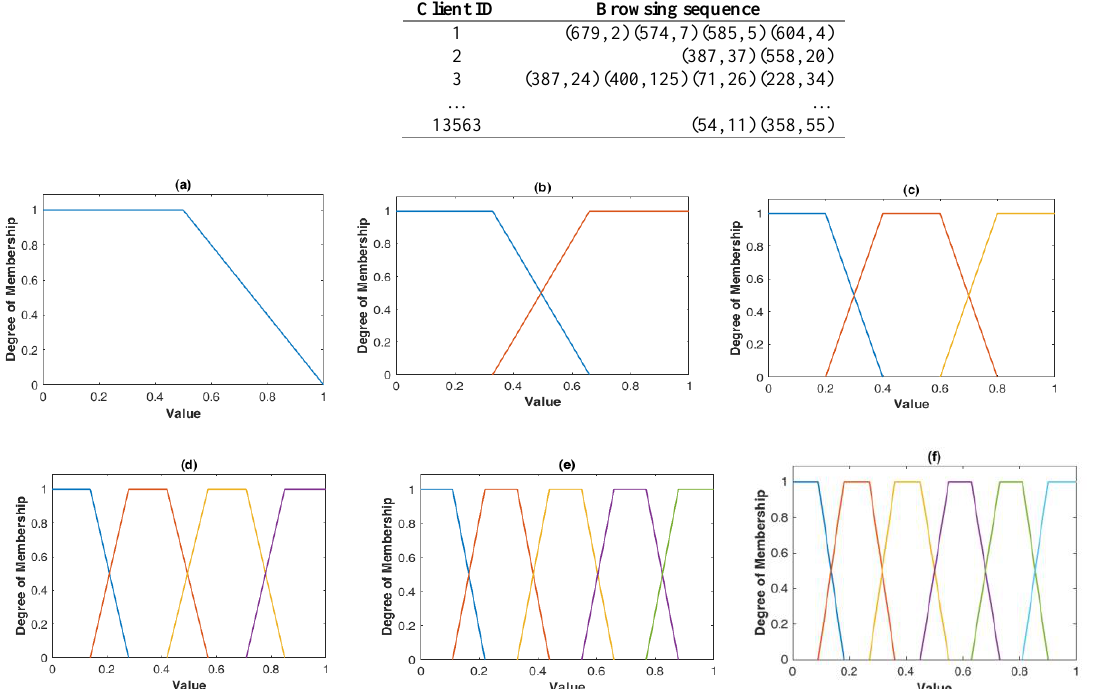
Table 5. List of client IDs along with browsing sequences by each user in the CTI dataset.